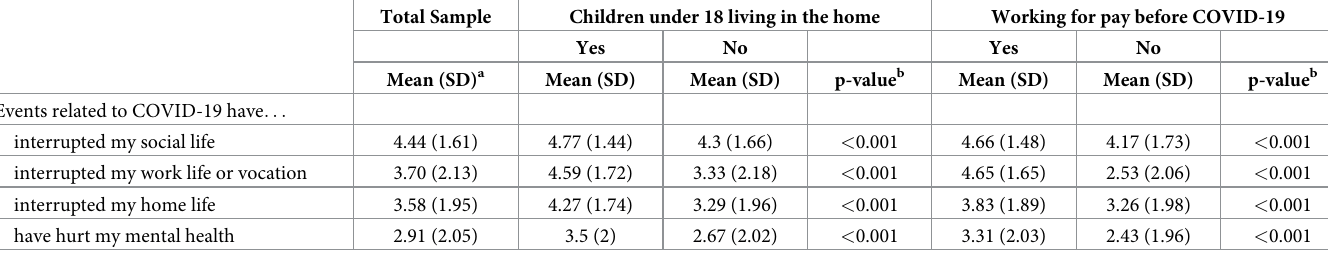
Table 5. Life disruption due to COVID-19: Overall, for those with/without children in the home, and for those working/not working for pay. Total Sample Children under 18 living in the home Working for pay before COVID-19 Yes No Yes Mean (SD) p-value b Events related to COVID-19 have